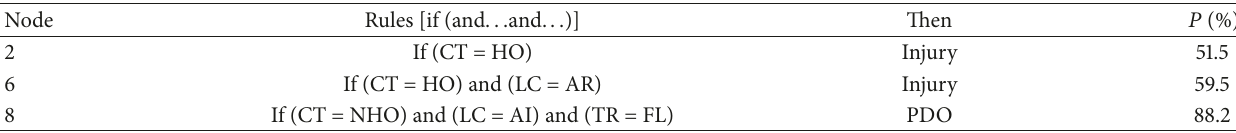
Table 2: Decision rules for crash severity of daylight